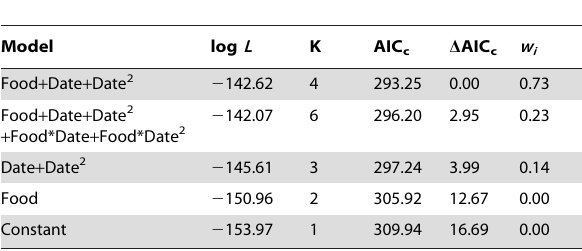
Table 4. Model selection results examining the effect of providing supplemental food for nest predators on the risk of nest predation for Dusky Flycatchers ( n = 76) from 2007 to 2008, Lake Tahoe,